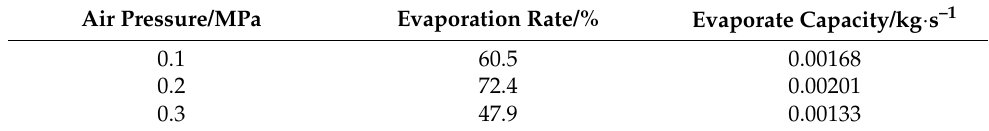
Table 1. Effect of compressed air pressure on evaporation rate and capacity (Q = 10 L/h, T = 70 ◦ C).